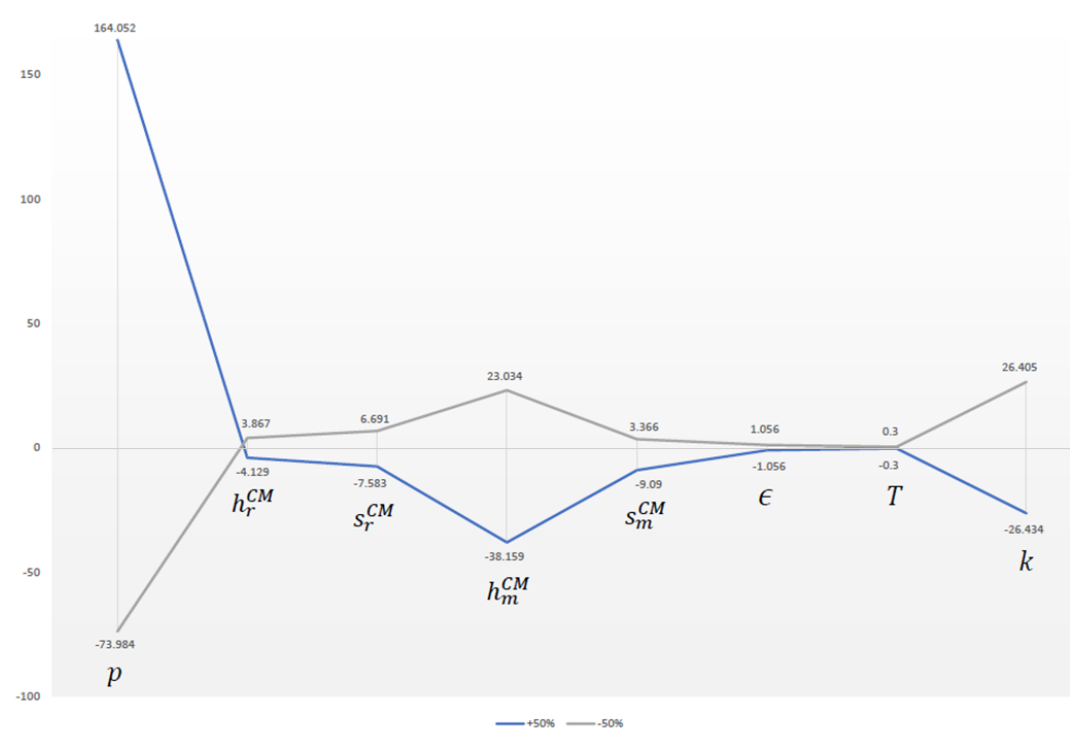
Figure 5. Graphical representation of sensitivity analysis between the range of − 50% to +